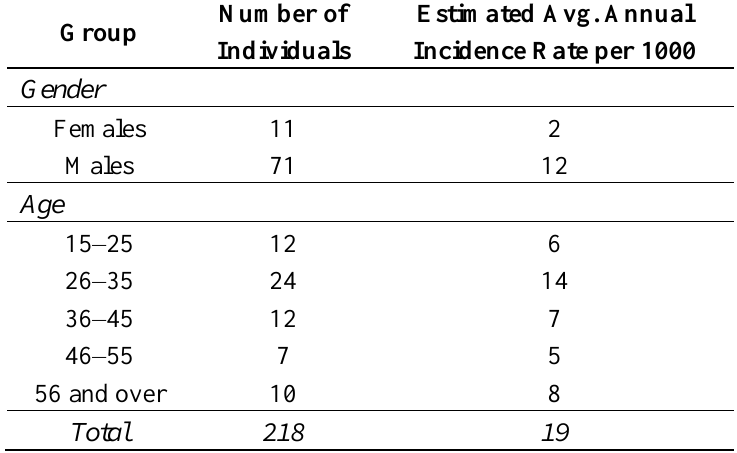
Table 1. Number of individuals in SAR cases and estimated annual incidence rate for SAR involvement of individuals from 1995 to 2010 for the Aboriginal population in Nain by gender and age.